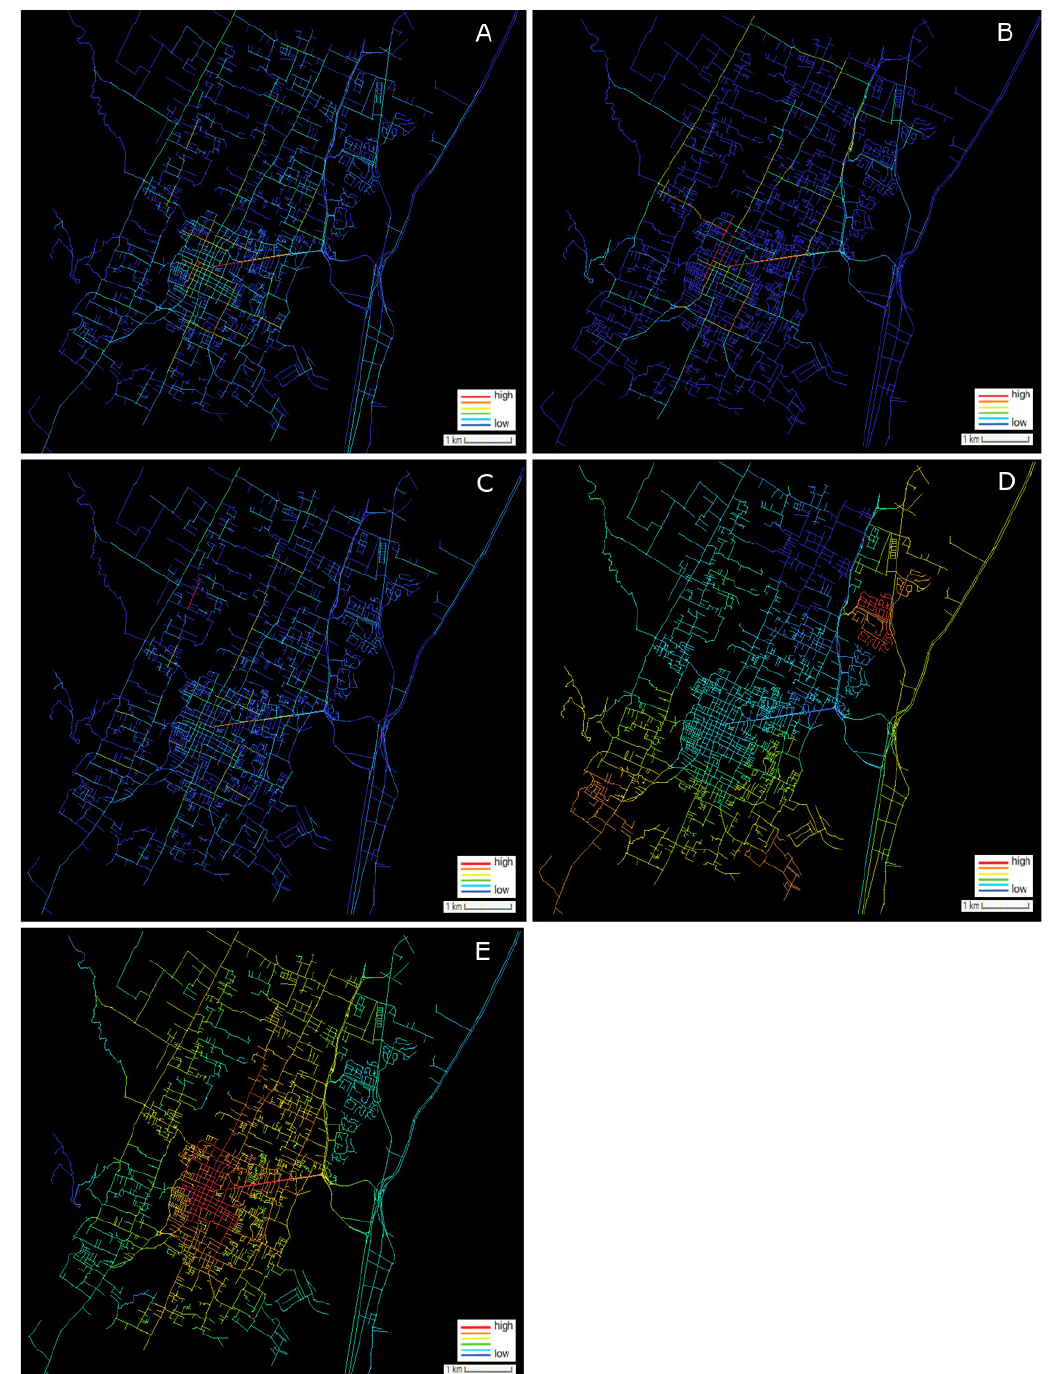
Figure 5. Axial maps of Chía’s urban space with the spatial variables: (a) connectivity, (b) choice, (c) control, (d) entropy, and (e) integration global